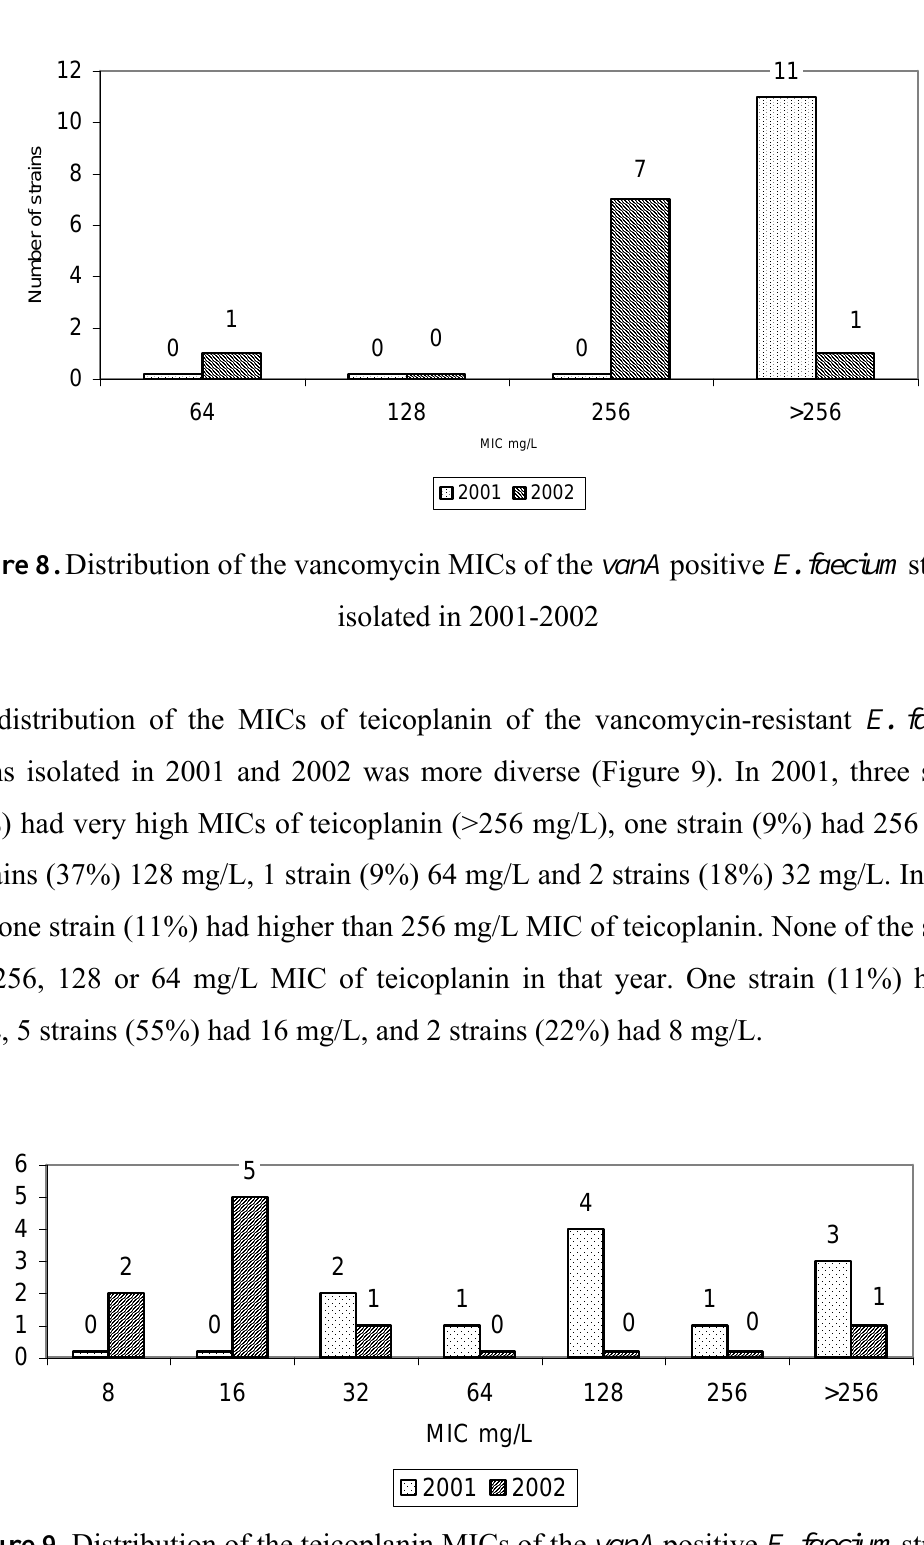
Figure 9. Distribution of the teicoplanin MICs of the vanA positive E. faecium strains, isolated in